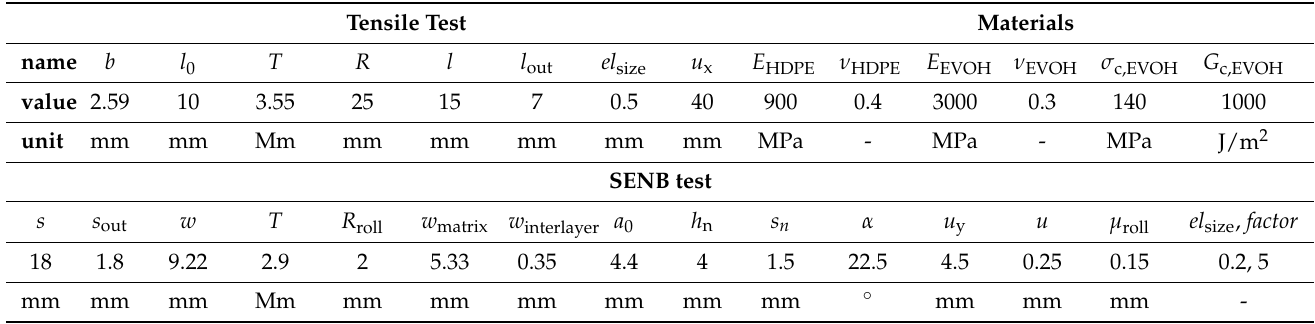
Table 1. Geometry, loading, and material parameters of the FEA models. Tensile Test Materials